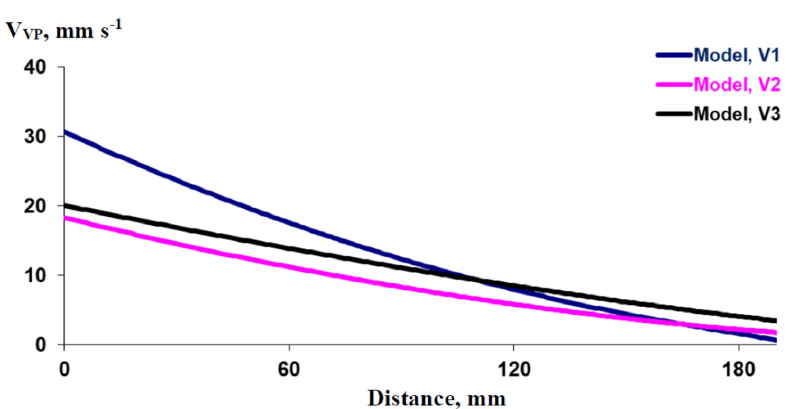
Figure 6. Simulated dependence of the propagation rates of variation potentials (V VP ) on the distance from the damaged zone in different variants of the model (see Figure 1b). The length of the xylem vessel (L) is assumed as 275 mm. The duration of hydraulic changes in the damaged zone (t R ) is assumed as 50 s. The ratio of the P’ integral, which is necessary for variation potential induction, to the total P 0 ’ integral in the zone of damage (N) is assumed as 0.3. Variant 1 (V1) of the model (instant initial increase in pressure and subsequent linear decrease), Variant 2 (V2) of the model (constant increased pressure for all time of response), and Variant 3 (V3) of the model (long-term increase in pressure and subsequent instant decrease in it) were